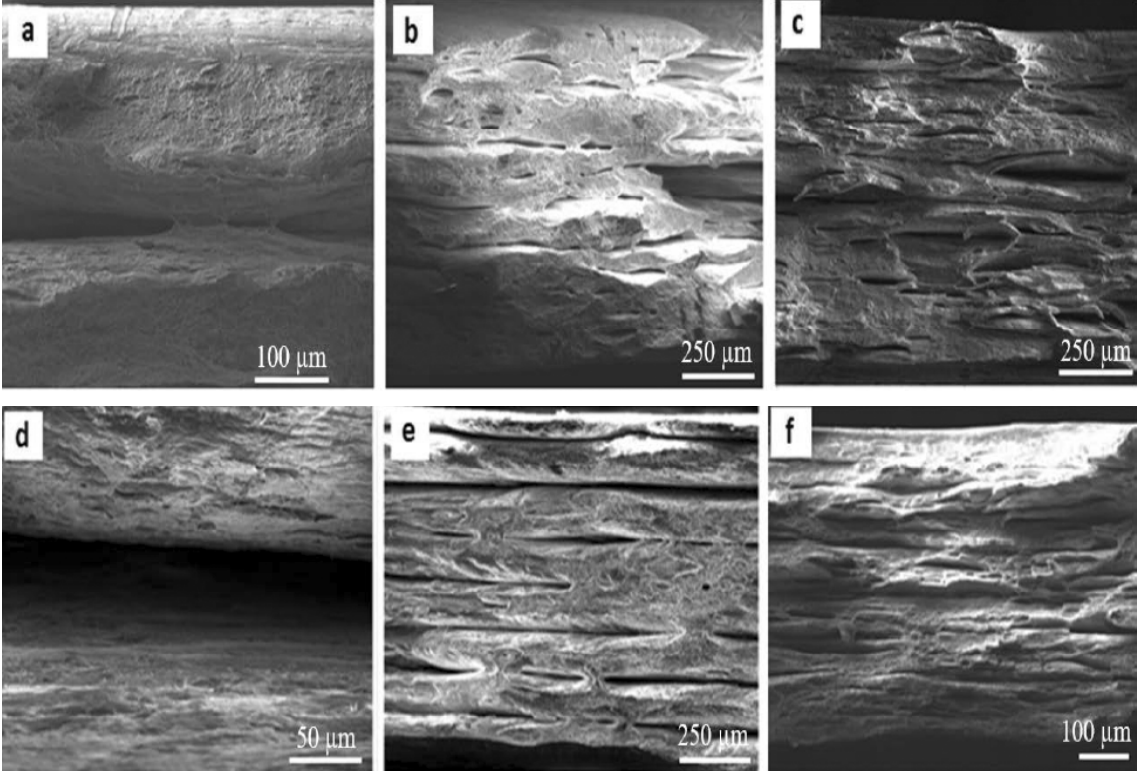
Fig. 10. The SEM images (150x and 300x) lead up to the fracture surface of the composites reinforced with micro- (a, b, c) and nanoparticles (d, e, f) produced after (a, d) first, (b, e) five and (c, f) seven cycles of the ARB